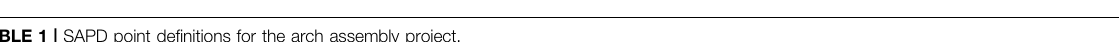
TABLE 1 | SAPD point de fi nitions for the arch assembly